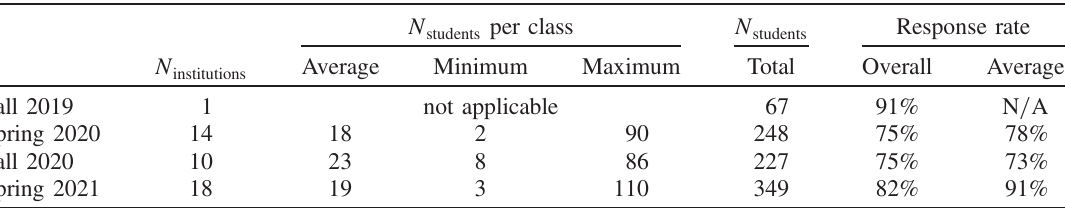
TABLE I. Information about the Fall 2019, Spring 2020, Fall 2020, and Spring 2021 pilot administrations of the U-STEP. In all cases, N here refers to the number of students enrolled rather than the number of responses. The Fall 2019 assessment versions were free-response, while the other versions were composed of CMR and MC items. Note the average response rate does not include classes with 0% response rate ( N ¼ 1 for Spring and Fall